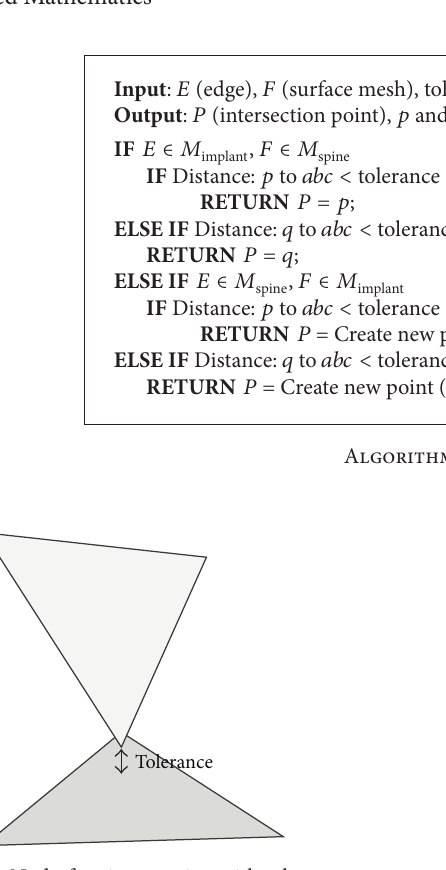
Figure 9: Node-face intersection with